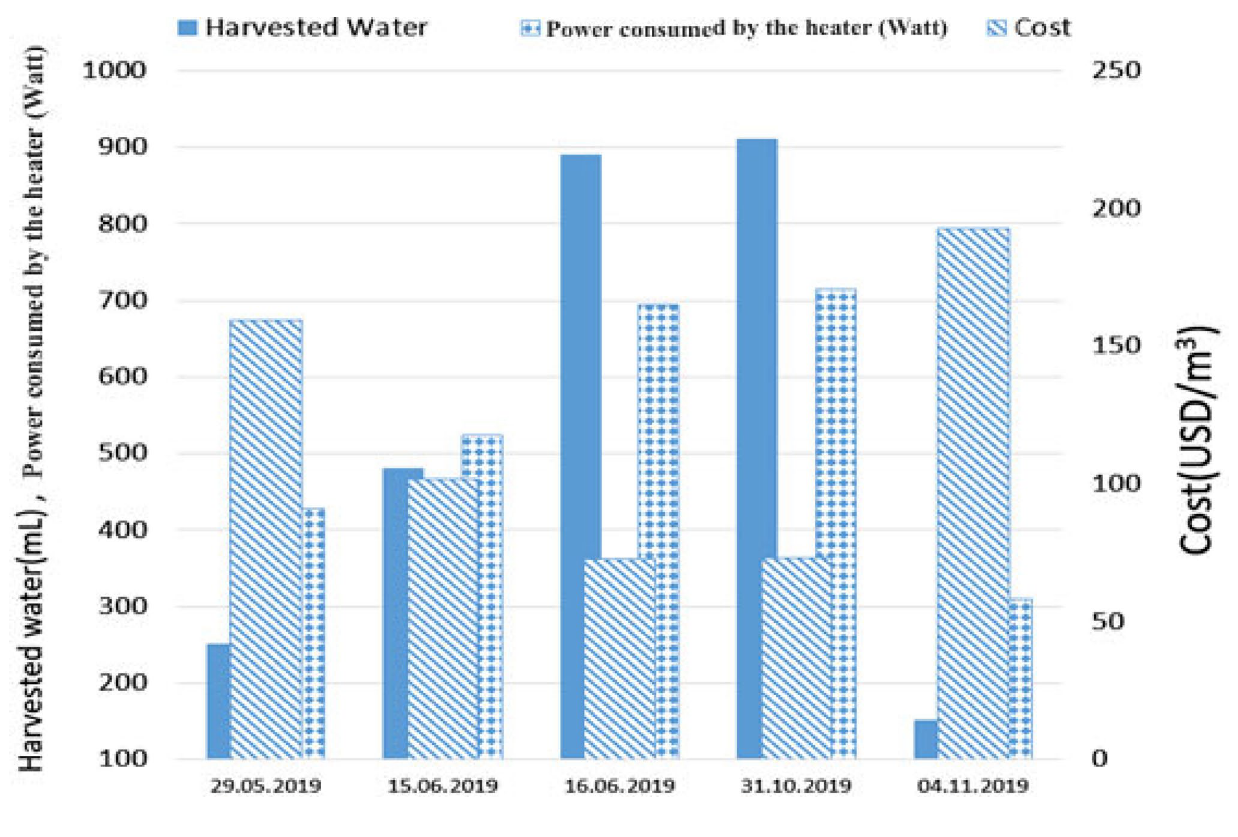
Fig. 12 Cost of water production Table 2 Unit costs of drinking water obtained using different